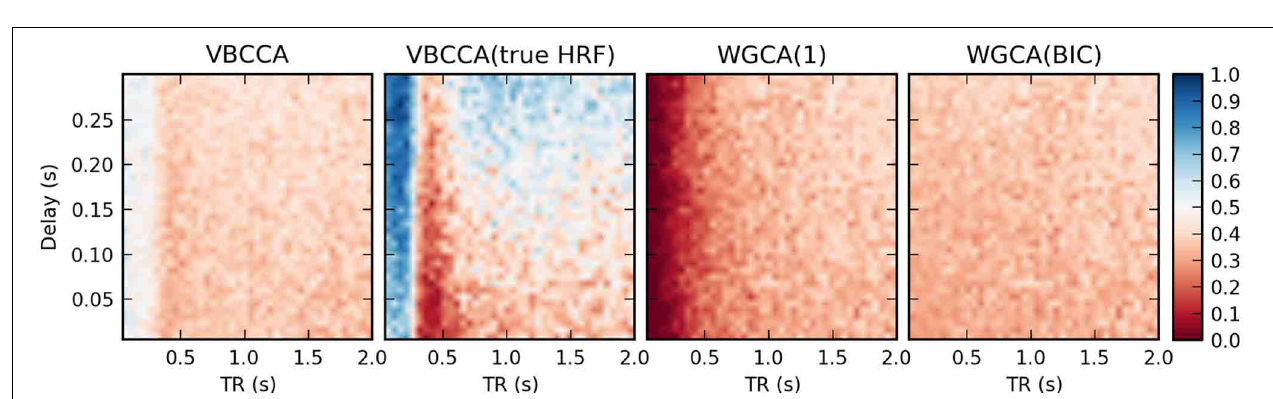
simulations, the signal-to-noise ratio is 0dB. The proposed method is denoted VBCCA and we use P = 1, whereas WGCA( P ) denotes the Wiener–Granger causality method, for which we use AR model orders of 1, 5, and an order between 1 and 20 selected using the Bayesian information criterion (BIC).